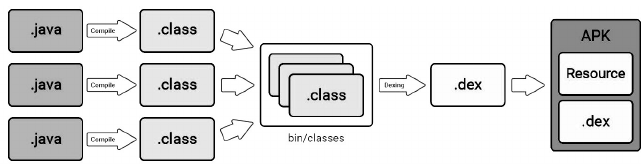
Figure 3. Dexing Java classes into